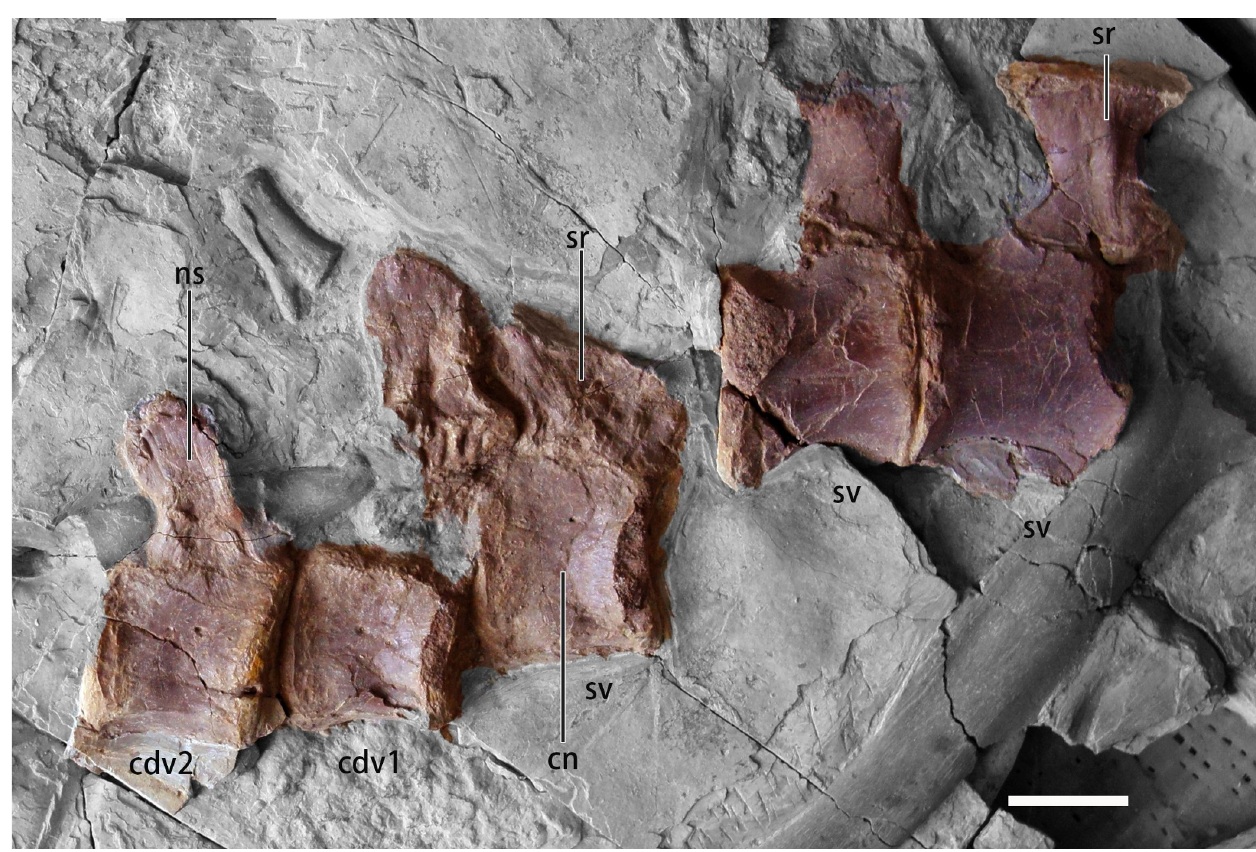
Fig 3. Photographs of sacral and anterior caudal vertebrae of B . inexpectus (IVPP V 11559). Abbreviations: cn, centrum; cdv1-2, caudal vertebrate 1–2; ns, neural spine; sv , sacral vertebrate; sr , sacral rib. Scale bars equal 2 cm.